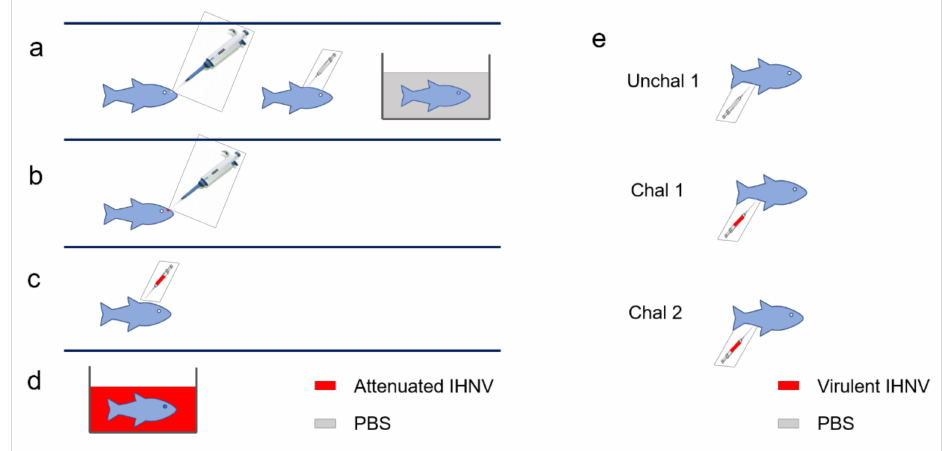
Figure 1. Diagram illustrating the vaccination routes and challenge experiments used in this study. ( a ) (control) received PBS into right nare, i.m. PBS injection and an 1 h immersion in PBS; ( b ) received IHNV vaccine in the right nare; ( c ) received an i.m. injection of IHNV vaccine; ( d ) received an 1 h immersion with IHNV vaccine; ( e ) Vaccination groups received PBS (Unchal 1 group, top) or virulent IHNV (Chal 1 group, (middle) and Chal 2 group (bottom) by intraperitoneal injection (i.p.) at 7 and 28 dpv, respectively. Unchal, unchallenged; Chal1 and Chal2 refer to duplicate tanks that were challenged for each experimental group at each time